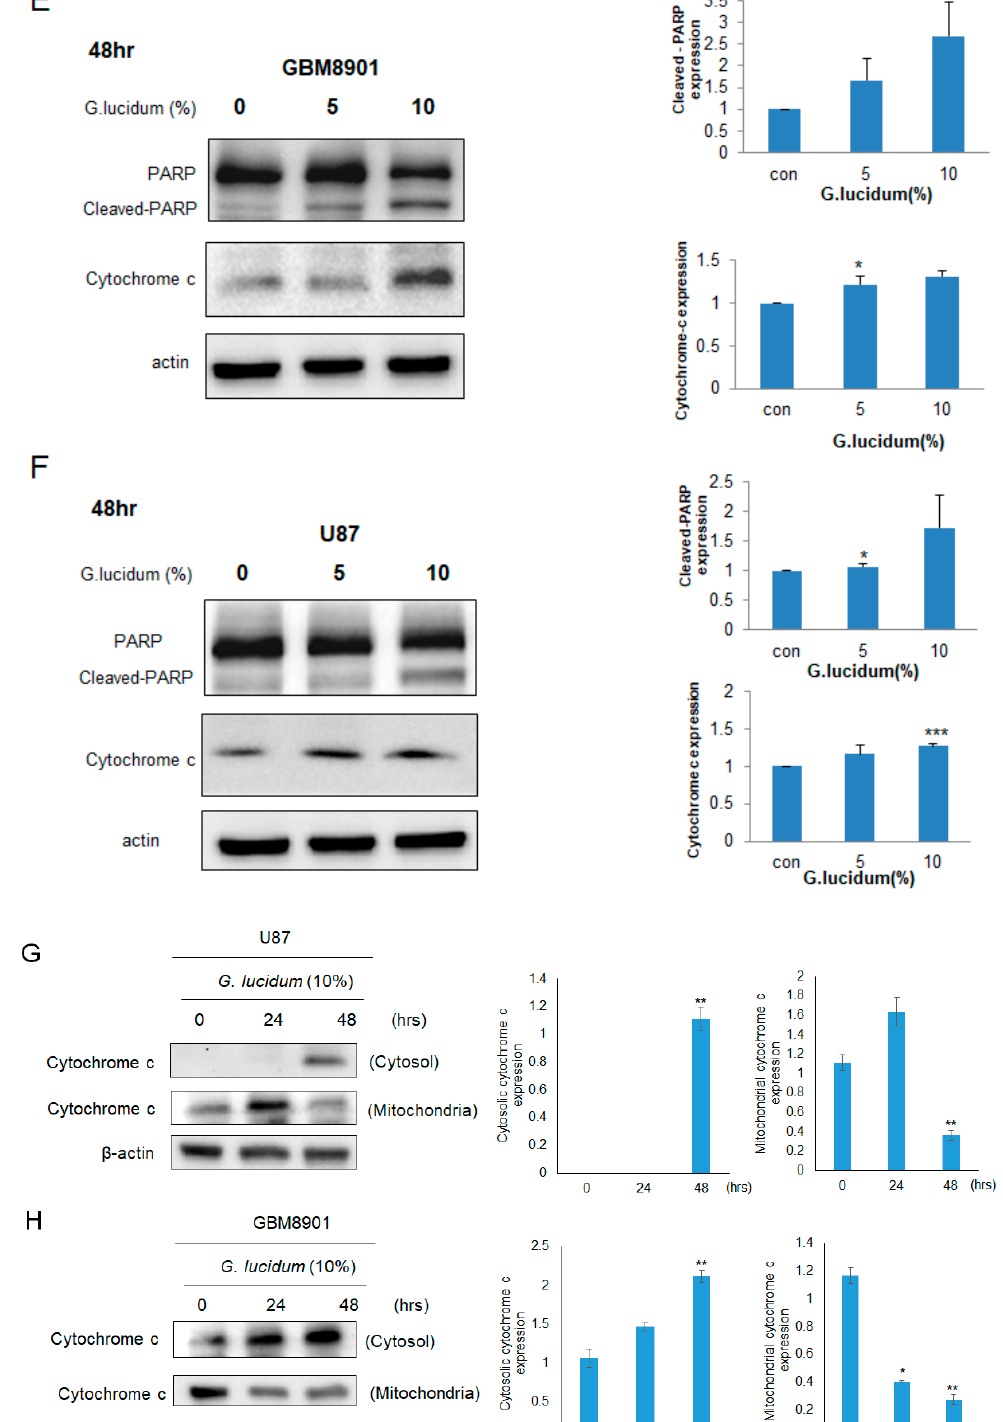
Figure 2. G. lucidum extract induces apoptosis in glioblastoma cells. ( A , B ) G. lucidum extract induces apoptosis of ( A ) GBM8901 and ( B ) U87 cells. ( C , D ) The straight bar chart shows the increase in apoptotic cells in the GMB8901 and U87 cells after treatment with G. lucidum in a time-dependent manner. ( E , F ) The expression of cell apoptosis-related proteins in ( E ) GBM8901 and ( F ) U87 cells as determined by Western blotting. ( G , H ) To detect cytochrome c release, cytosolic and mitochondrial fraction of ( G ) U87 and ( H ) GBM8901. * p < 0.05; ** p < 0.01; *** p <